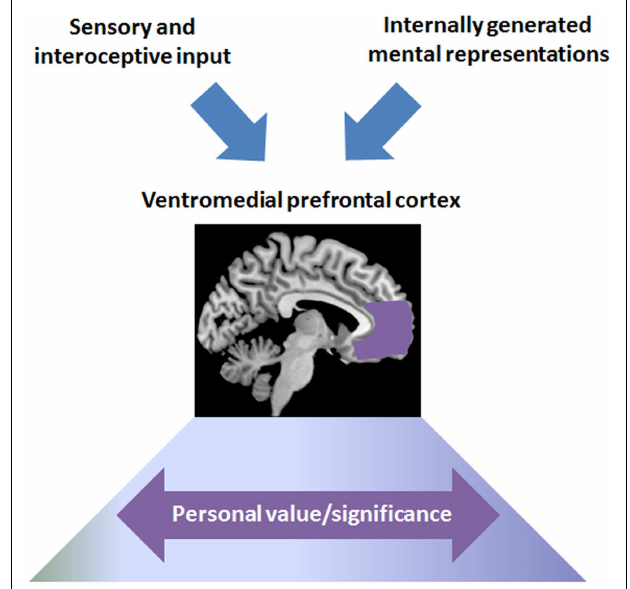
FIGURE 1 | Schematic representation of the function of the vMPFC according to the valuation hypothesis .The vMPFC may represent the personal value or significance of various types of information, not only stimuli from the external and internal environment (i.e., sensory and interoceptive input) but also internally generated mental contents (e.g., thoughts, images, memories), including self-representations. Personal significance is processed along a continuum, such that stimuli and mental contents are assigned degrees of